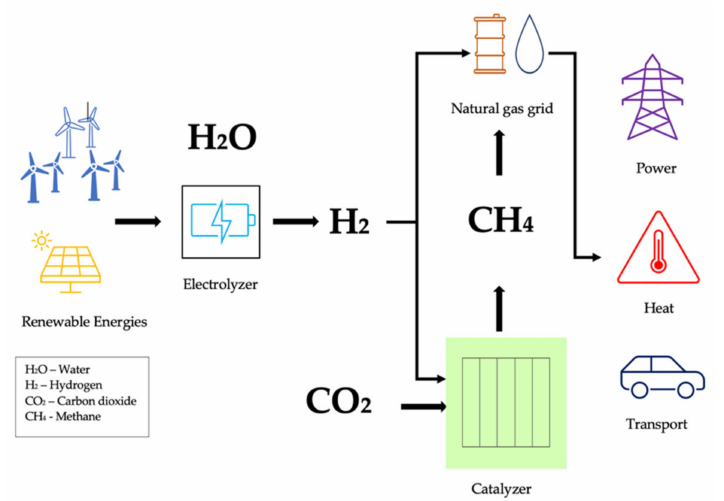
Figure 8. Schematic illustration of “power to gas” (PtG) technology (adapted from Younas